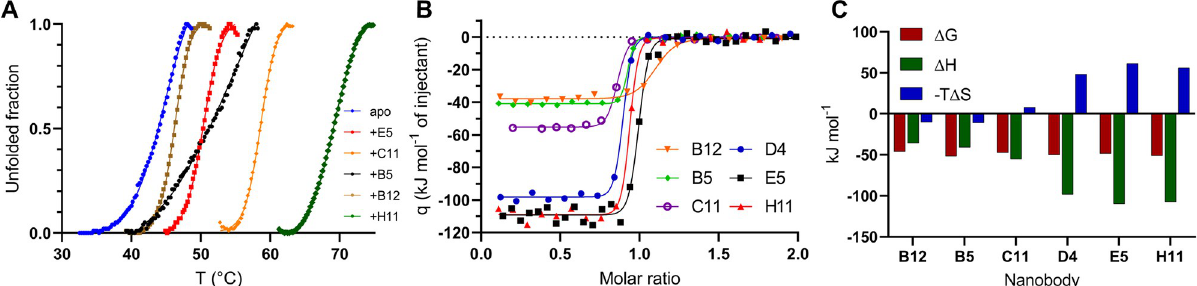
Fig 4. Nb binding to FLrArc-7A. A DSF melting curves of apo FLrArc-7A and in complex with Nb. Portions of the curves, other than the unfolding transition, are not shown for clarity. T m values are shown in Table 1. B ITC titrations of Nb into FLrArc-7A. Raw ITC thermograms can be seen in S2 Fig. C Contributions of Δ H and Δ S to the Δ G of Nb binding, highlighting enthalpy-entropy